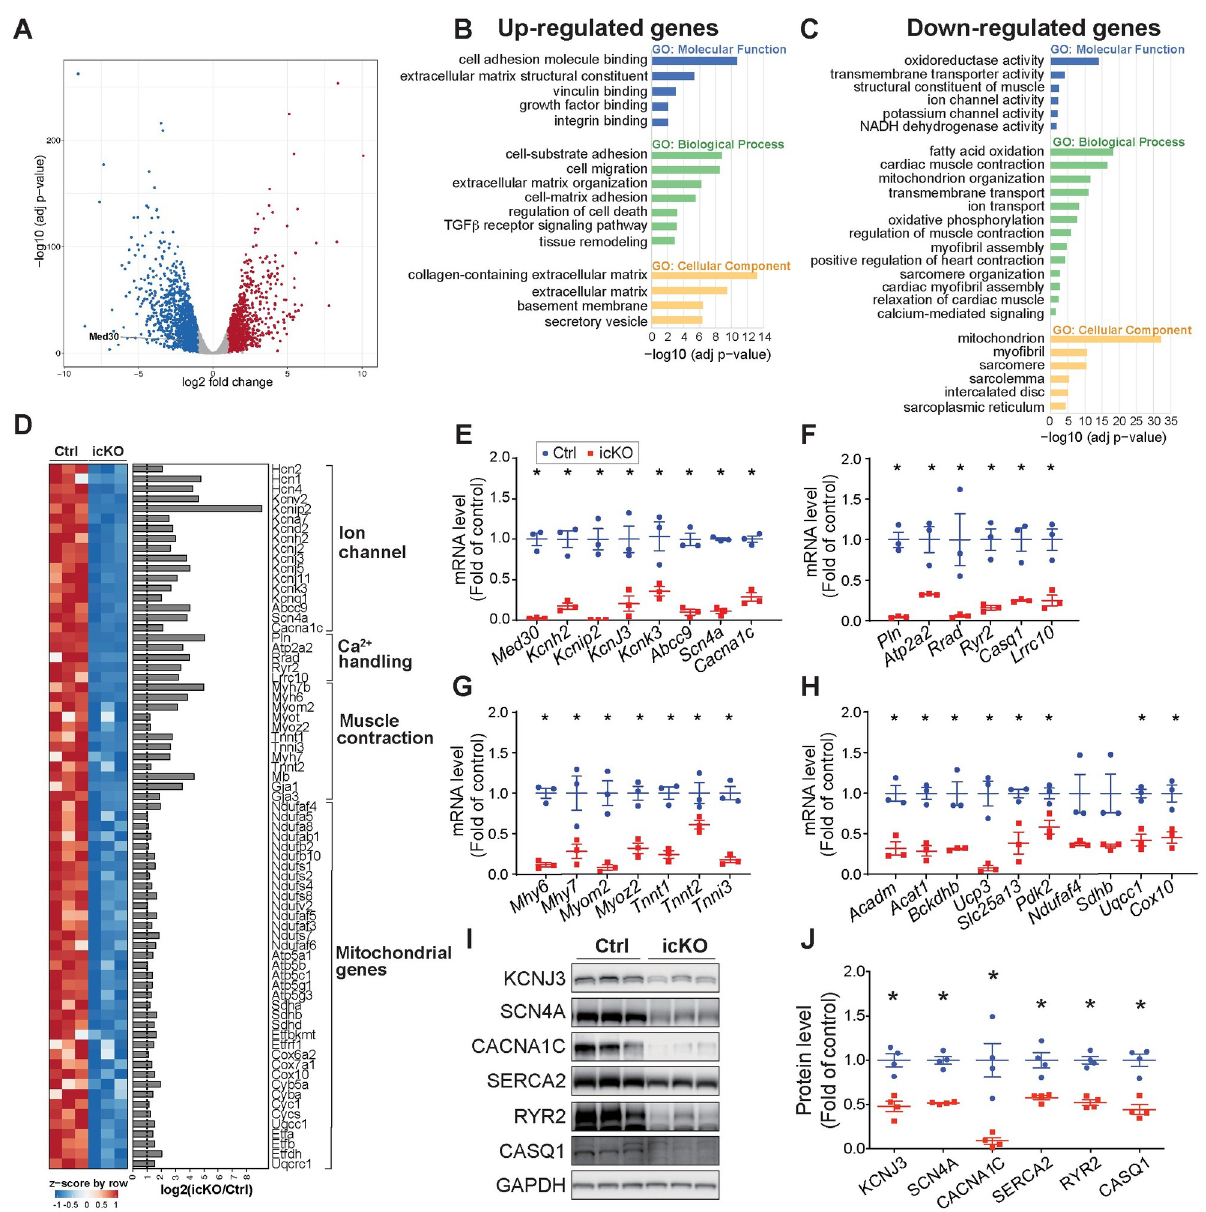
Fig 6. Transcriptome analysis in MED30 deletion adult cardiomyocytes. (A) Volcano plot obtained from DESeq2 analysis of gene expression in adult cardiomyocytes isolated from Med30 icKO versus control hearts at 4 weeks post-tamoxifen injection. Genes with adjusted P < 0.05 and log2 (fold change) > 1 are considered significantly upregulated or downregulated genes in Med30 icKO cardiomyocyte. The upregulated or downregulated genes are highlighted in red and blue, respectively. (B-C) Gene Ontology (GO) analysis of significantly upregulated (B) and downregulated (C) genes in cardiomyocytes isolated from Med30 icKO at 4 weeks post-tamoxifen injection. (D) Heatmap (left) and bar graph of log2 (fold change) (right) for downregulated genes involved in ion channels, Ca 2+ handling, muscle contraction and mitochondrial genes. (E-H) qRT-PCR validation of RNA-seq data for genes involved in ion channels (E), Ca 2+ handling (F), muscle contraction (G), and mitochondrial genes (H), in adult cardiomyocytes isolated from Med30 icKO (red) versus control (Ctrl) (blue) at at 4 weeks post-tamoxifen injection. n = 3. (I, J) Representative immunoblots (I) and quantification analysis (J) of KCNJ3, SCN4A, CACNA1C, SERCA2, RYR2 and CASQ1 in adult cardiomyocytes isolated from Med30 icKO and control (Ctrl) hearts at 4 weeks post-tamoxifen injection. GAPDH served as a loading Ctrl. n = 3. All Data represent mean ± SEM. Statistical significance was based on student’s t test, � , P <